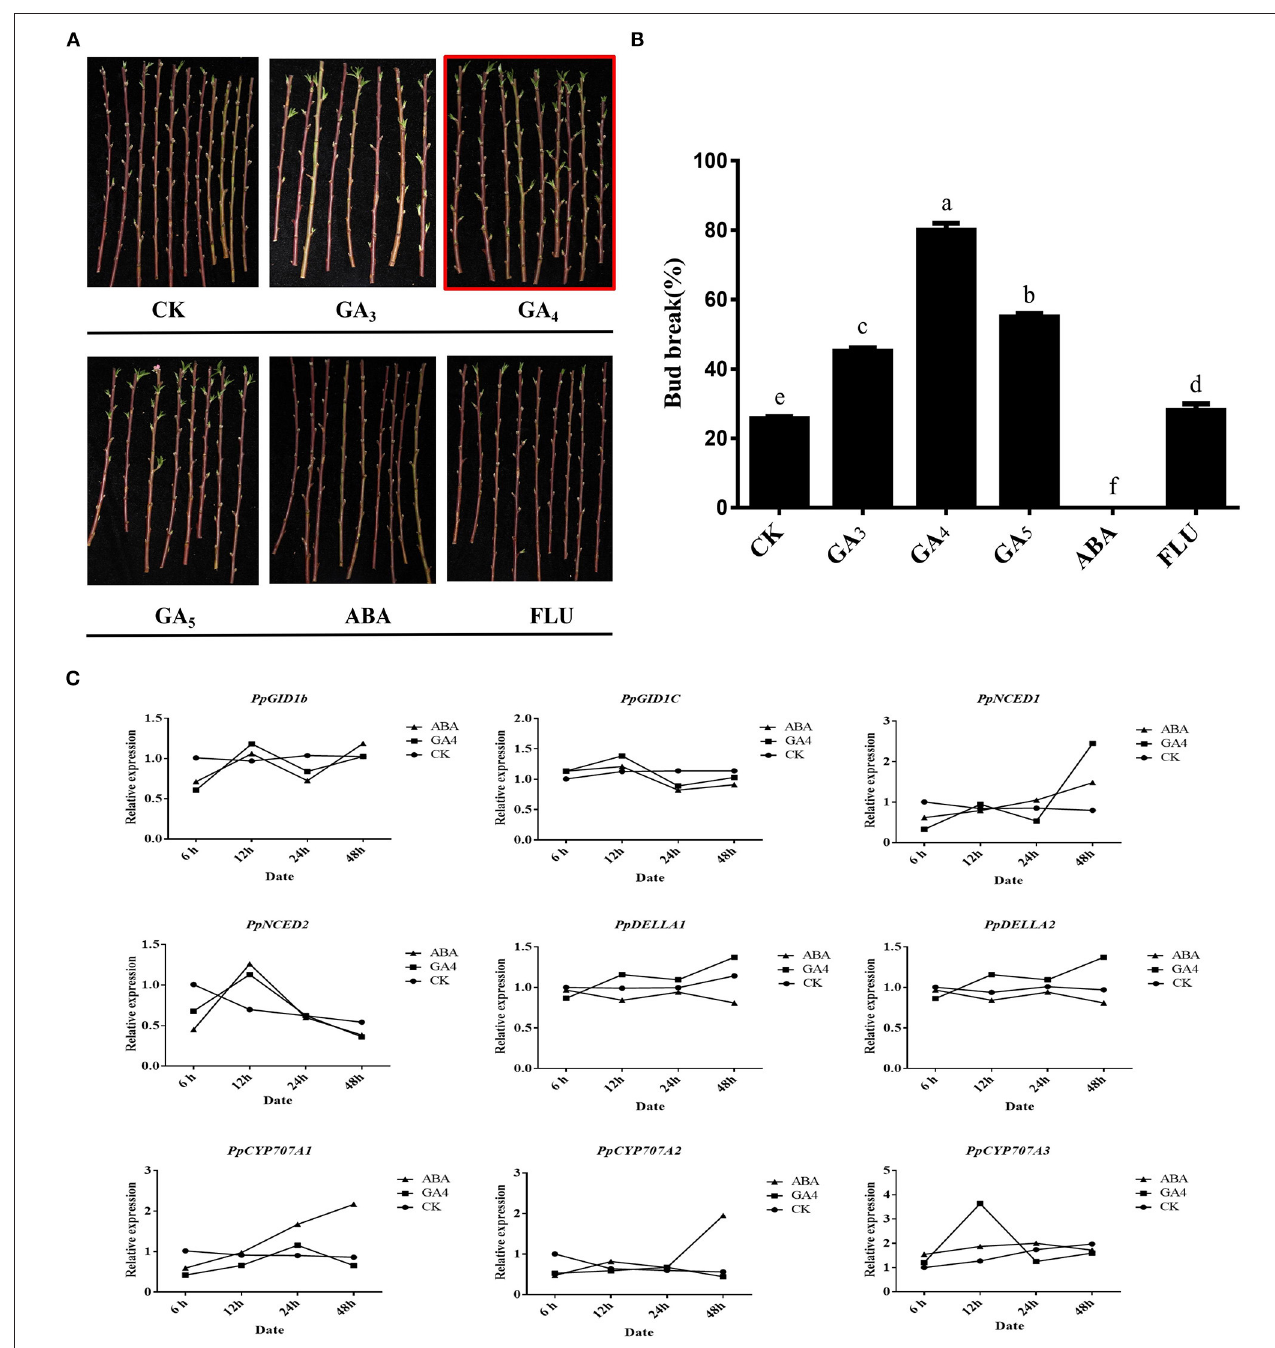
FIGURE 4 | Effects of different hormone treatments on the burst of peach leaf buds. (A) Effects of different hormone treatments (GA 3 , GA 4 , GA 5 , ABA, and FLU) on the burst of leaf buds. (B) Calculation of peach leaf buds breaks rate. (C) Effects of GA 4 and ABA treatments on GA and ABA signaling pathway gene expression.